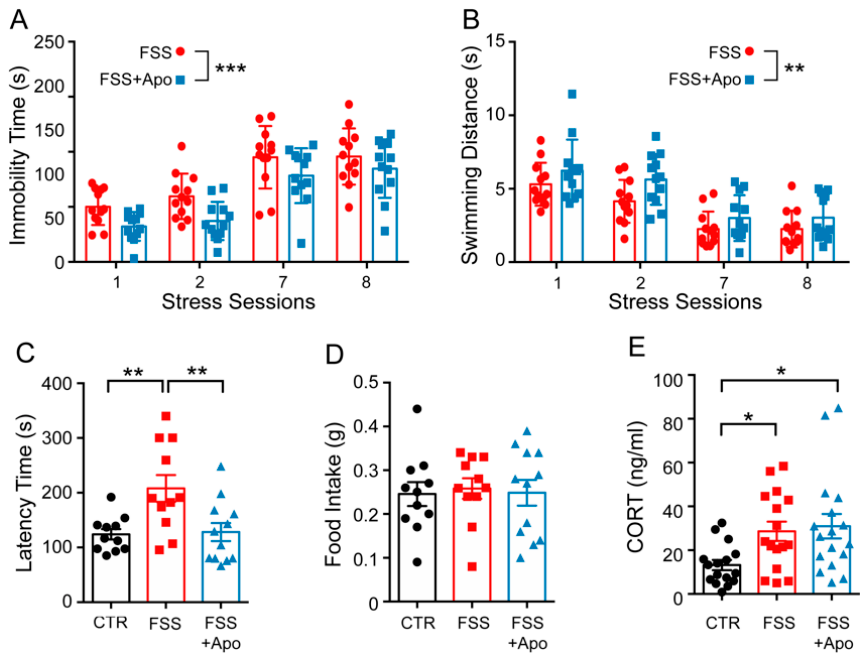
Figure 1. Apocynin prevents FSS-induced behavioral impairments. ( A , B ) Immobility time ( A ) and swimming distance ( B ) measured during the first and the last day of Forced Swimming Stress (FSS) exposure. Repeated two-way ANOVA. Data are presented as Mean ± SEM ( n = 12 mice/group). ( C , D ) Novelty-Suppressed Feeding (NSF) test. Latency to bite the pellet food in a new large arena ( C ) and the amount of food consumed in the home cage ( D ). One-way ANOVA followed by Tukey’s post hoc analysis ( n = 11–12 mice/group). ( E ) Plasmatic corticosterone levels measured 48 h after the last session of stress. One-way ANOVA followed by Tukey’s post hoc analysis. Data are presented as Mean ± SEM ( n = 16–17 mice/group). * p < 0.05; ** p < 0.01; *** p < 0.001.